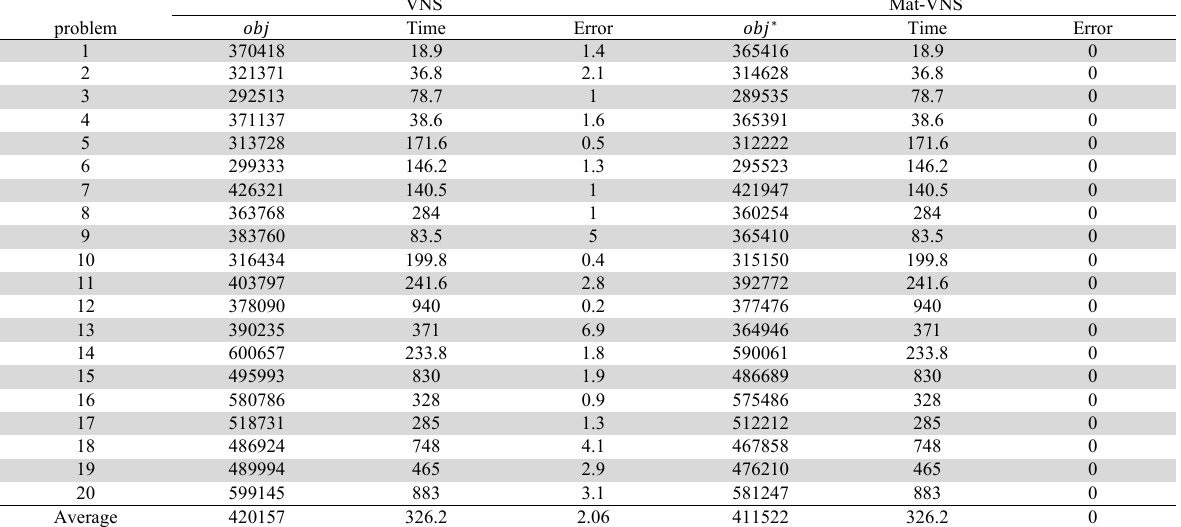
Obtained results from VNS and Mat-VNS algorithms for large scale